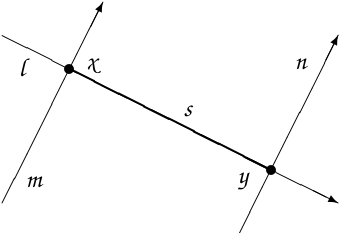
Figure 2. Utilized representations { x , y } and { l , m , n } of a straight line segment s . The oriented straight lines m and n de- limit the segment s and are perpendicular to the straight line l .